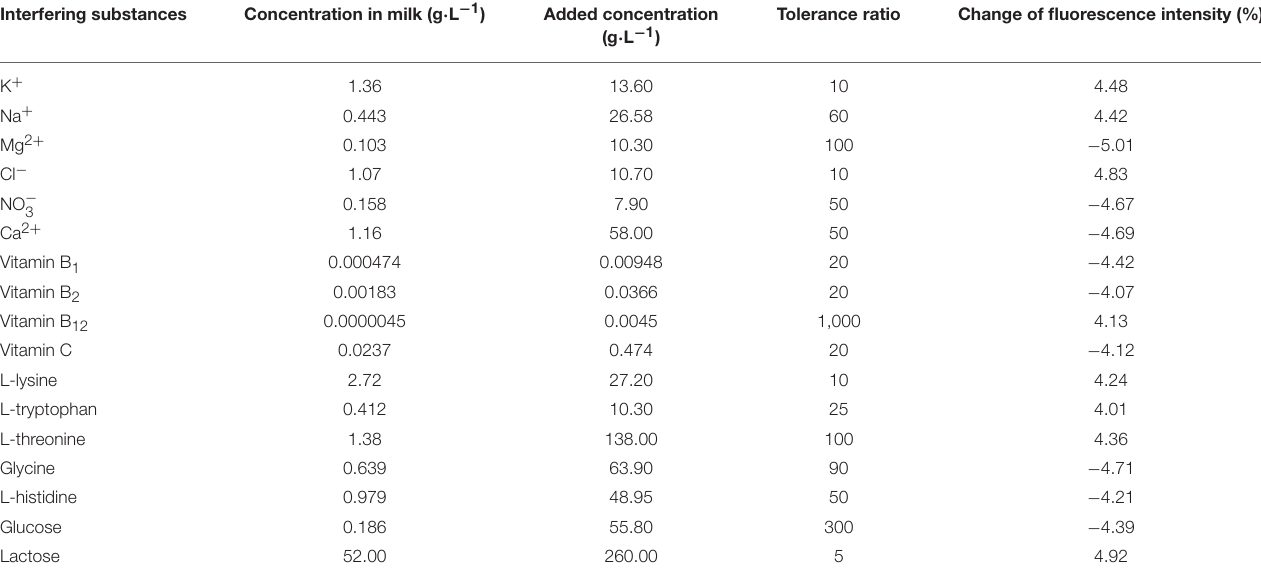
TABLE 1 | The influences of various potential interfering substances on the fluorescence intensity of the detecting system. Interfering substances